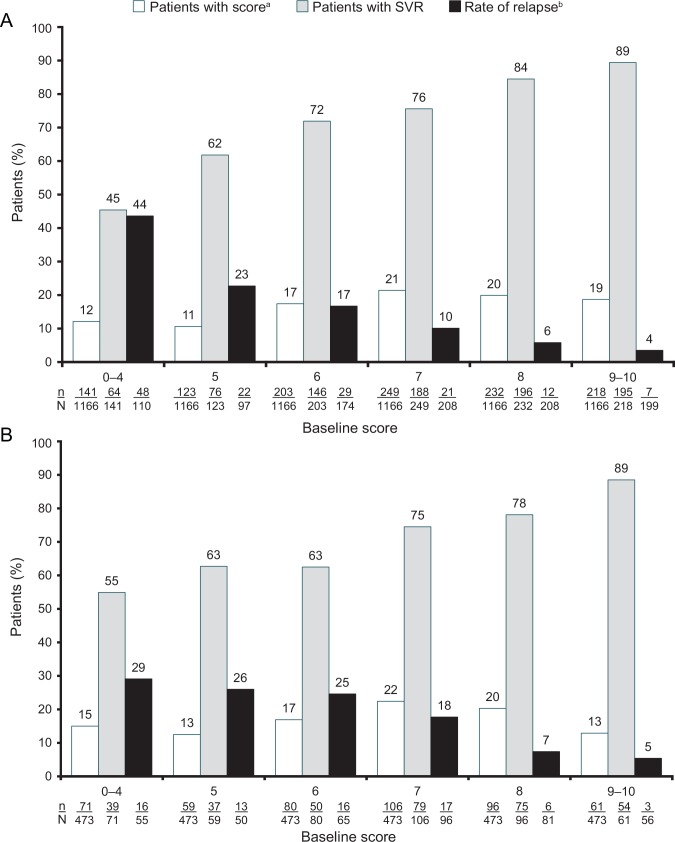
Sustained virologic response and relapse rates in treatment-naive Caucasian patients with HCV genotype 3 by baseline prediction score.A) Development cohort; B) Validation cohort SVR = sustained virologic response 24 weeks post-treatment. a 73 patients did not have a score and were omitted; of these, 46 (63.0%) achieved SVR. b Patients with end-of-treatment response and sufficient follow-up.